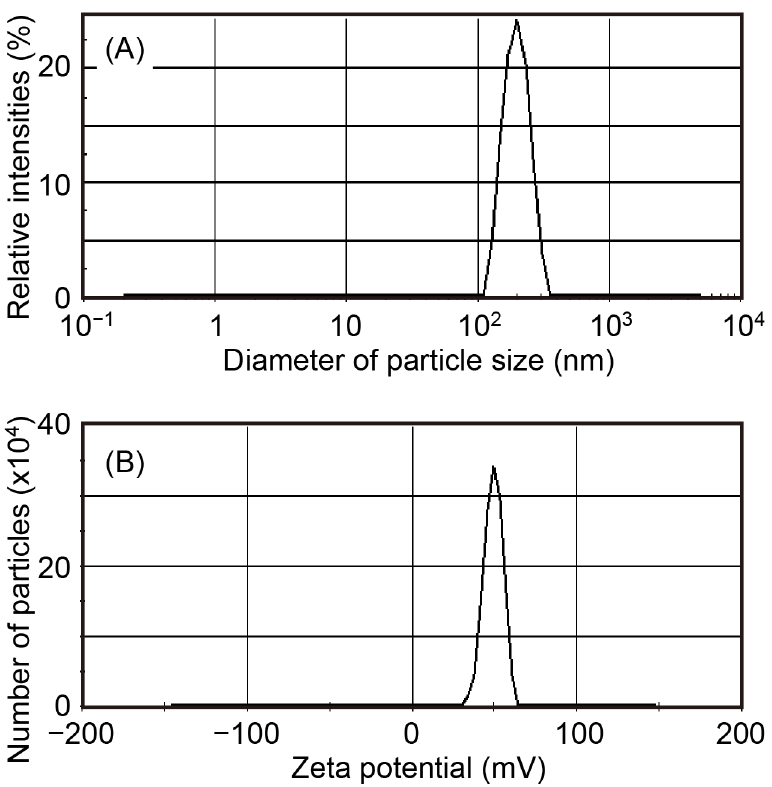
Figure 3. Particle size ( A ) and zeta potential values ( B ) of CKR12-PLGA conjugate micelle.